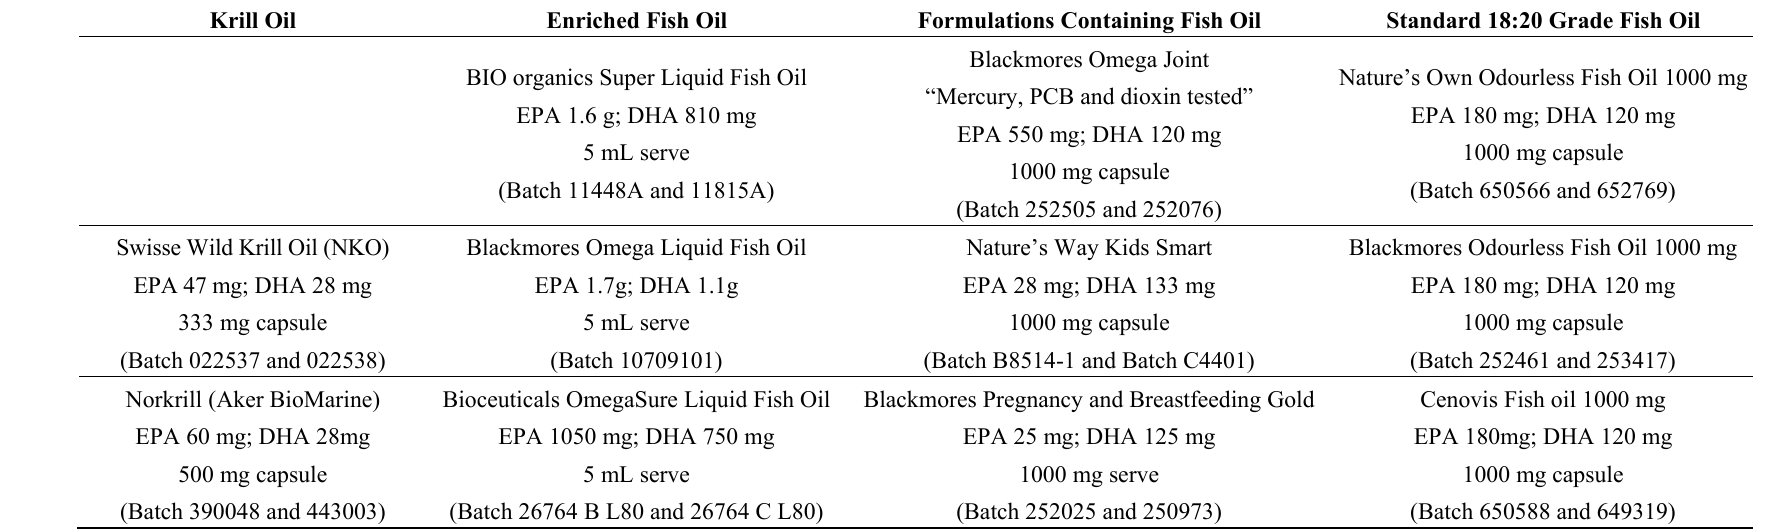
Table 1. Selected fish and krill oil nutriceutical products compared in this study. Capsules or subsamples from two separate batches of each product were pooled for each fatty acids (FA) analysis, except for Blackmores Omega Liquid Fish Oil for which only a single batch number could be